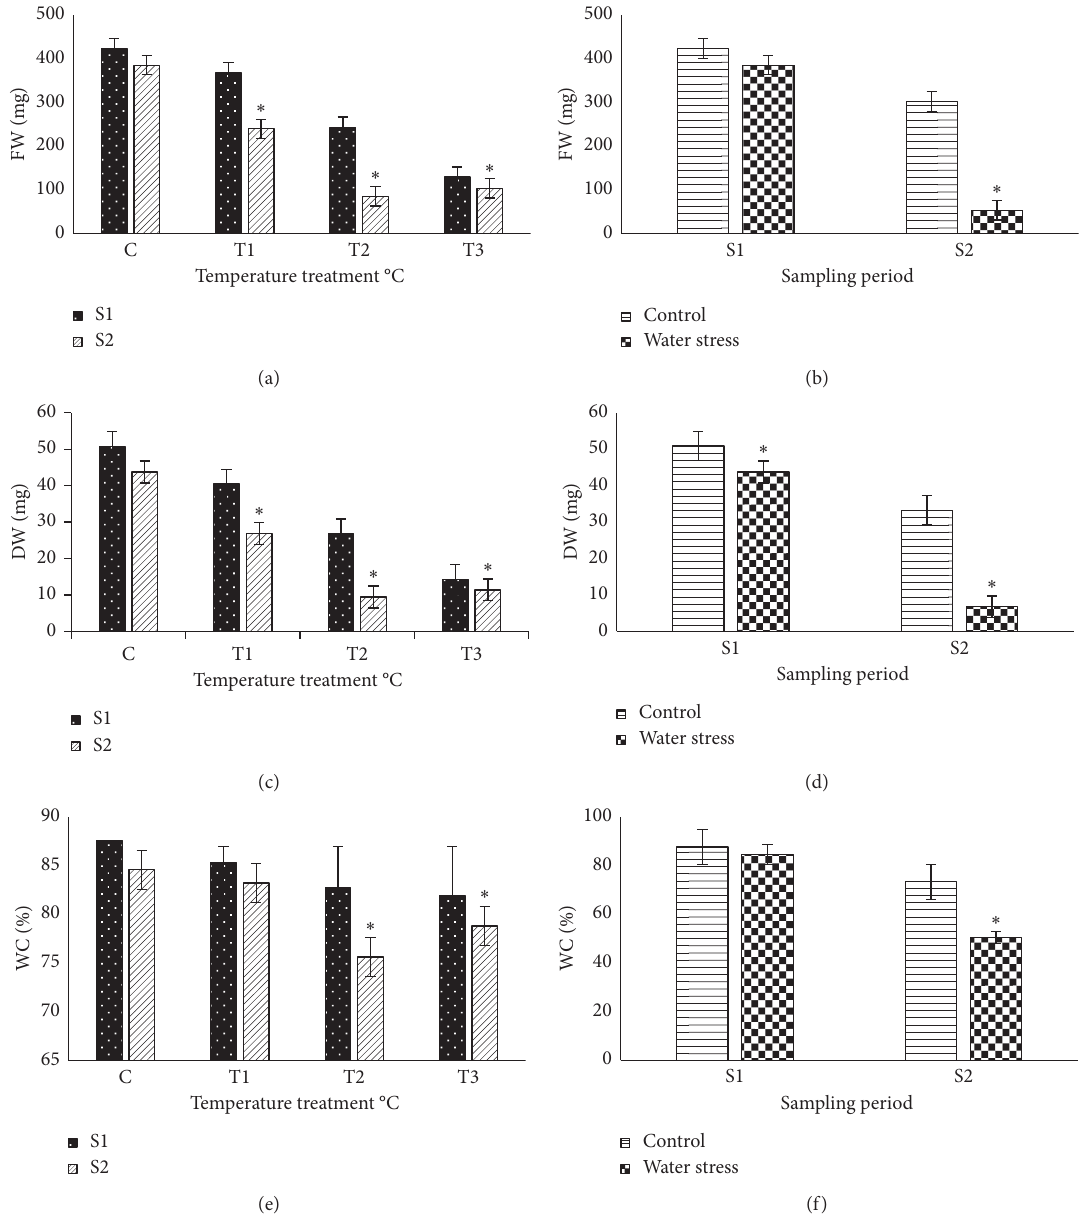
Figure 3: Effect of different climate temperatures (C, 25 ° C; T weight, FW (a, b); dry weight, DW (c, d); and water content (e, f) after two sampling periods (S1, 14 days and S2, 21 days) in basil plants (mean ± SD, n � 10). Asterisks indicate significant differences between sampling periods of each treatment and differences between treatments for the same sampling period according to the Tukey test ( α �